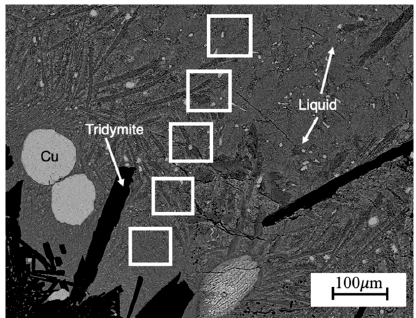
Figure 2. Scanning electron micrograph of a quenched liquid slag equilibrated for 3 h saturated with tridymite and metallic copper. The white squares indicate the analyzed areas.